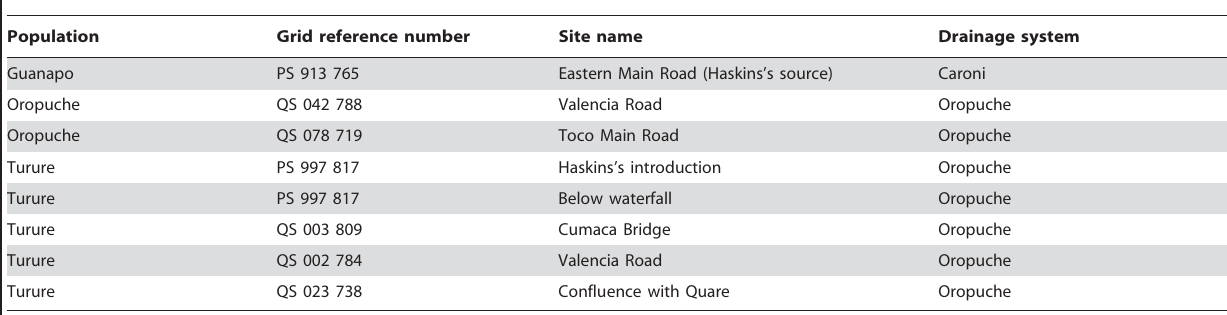
Table 2. Grid references of catching sites.